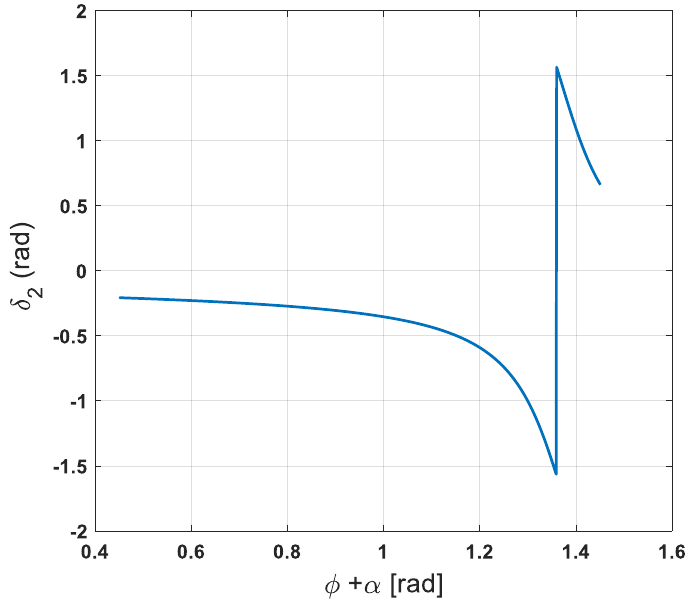
Figure 6. The dependence of the load angle δ 2 on the angle ( ϕ + α )